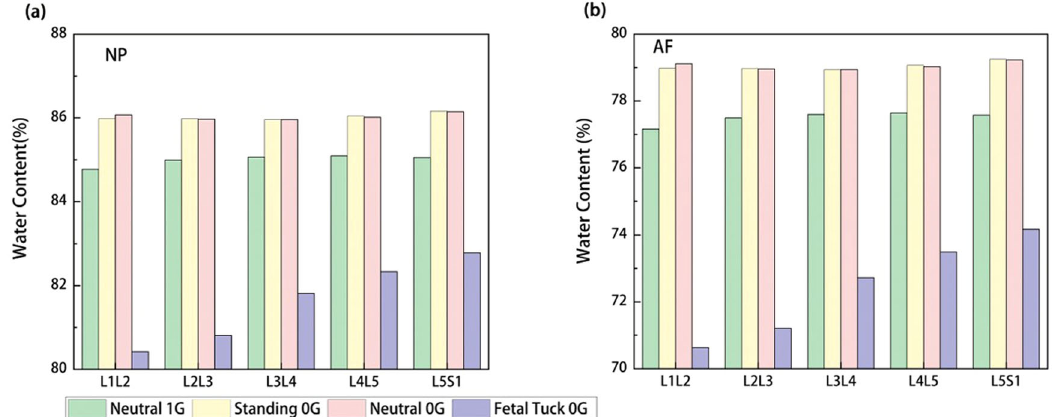
Fig. 4 Comparison of water content in lumbar discs among various postures in 1G gravity and microgravity. Water content in a NP and b AF among Neutral 1G, Standing 0G, Neutral 0G, and Fetal Tuck 0G. NP nucleus pulposus, AF annulus fi